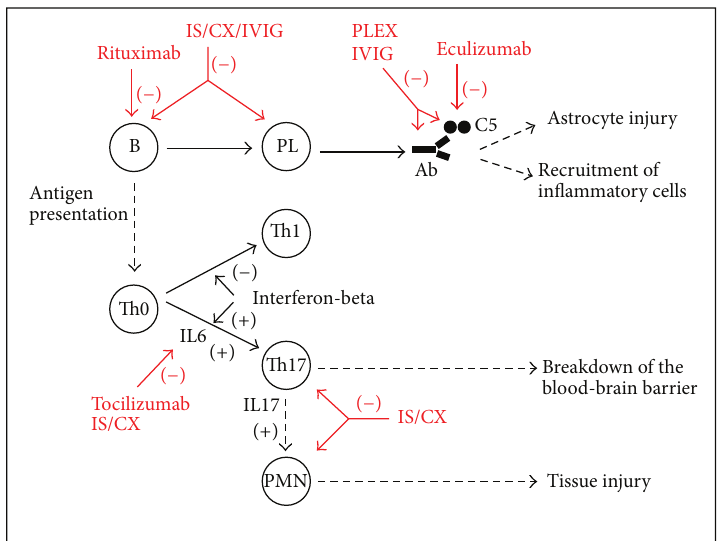
Figure 1: Summary of the mechanisms of action of immunotherapies in NMO. Abbreviations: B = B cell, C 5 = protein 5 of complement, CX = cytotoxic agent, IL = interleukin, IS = immunosuppressant, IVIG = intravenous immunoglobulin, PL = plasma cell, PMN = polymorphonuclear cell, Th = T helper